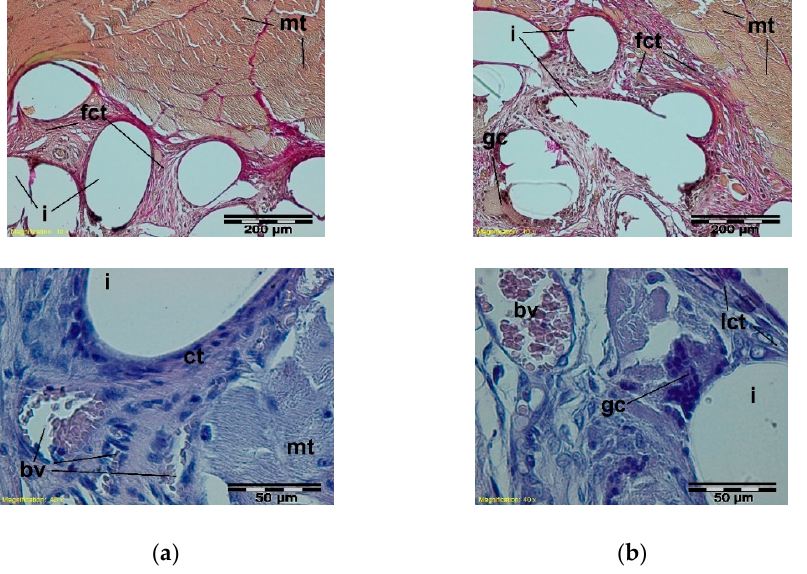
Figure 7. A microscopic view of the PACVD modified sample ( a ) and the reference ( b ) 3 weeks after the intramuscular implantation. In the muscles (mt), the implant monofilaments are surrounded by connective tissue (fct) with numerous blood vessels (bv). A loose connective tissue with single giant cells in the immediate vicinity of the knitted structure is visible. Magnification 100×, Stain. VG; Magnification 400×, Stain. HE.